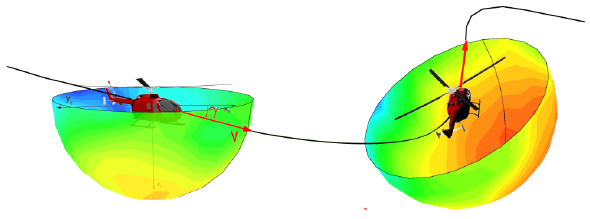
Figure 1: Noise hemisphere